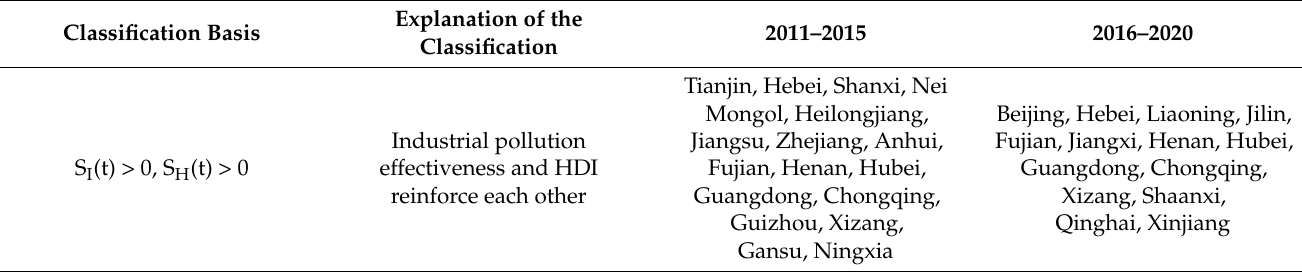
Table 2. Classification of the force-on index of industrial pollution